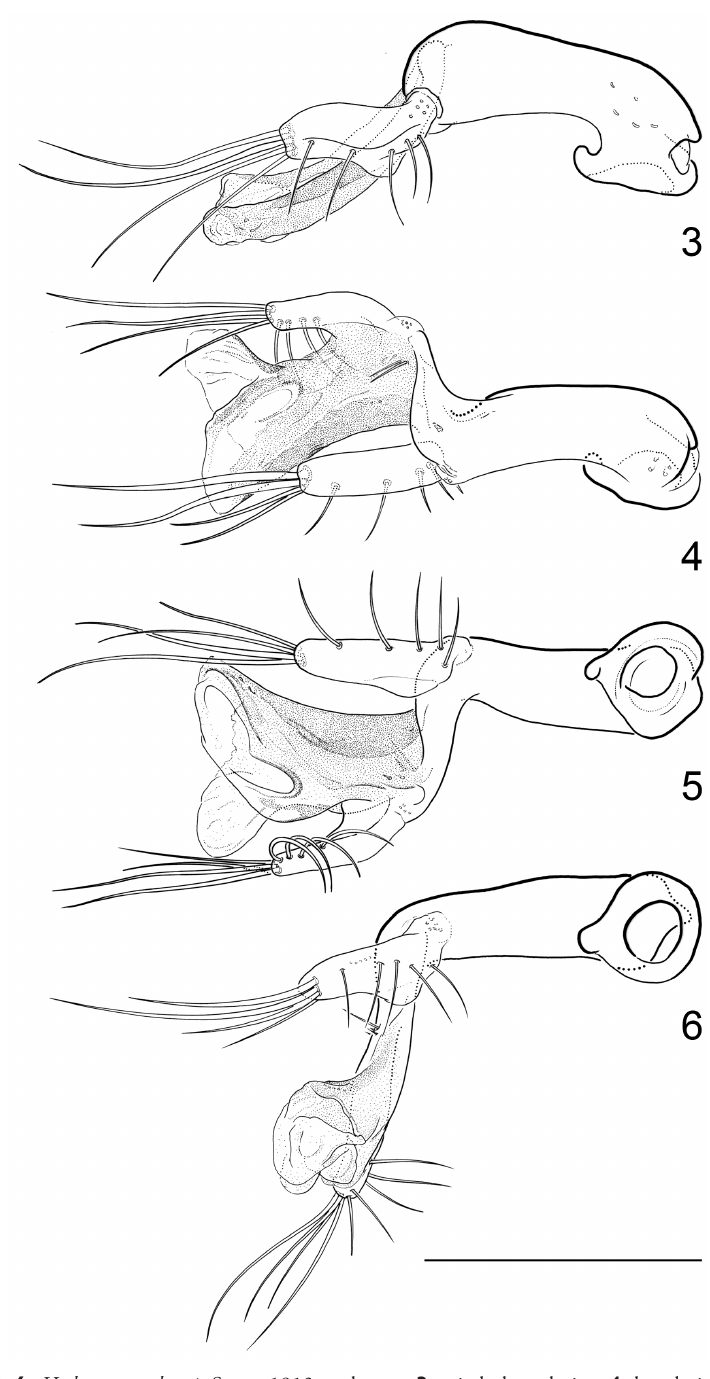
Figures 3–6. Hydraena mahensis Scott, 1913, aedeagus: 3 strictly lateral view 4 dorsal view 5 strictly ventral view 6 ventral view, slightly rotated to left side. Scale bar: 0.1